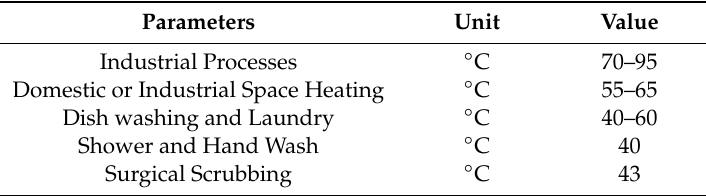
Table 2. Hot water temperatures for industrial applications.